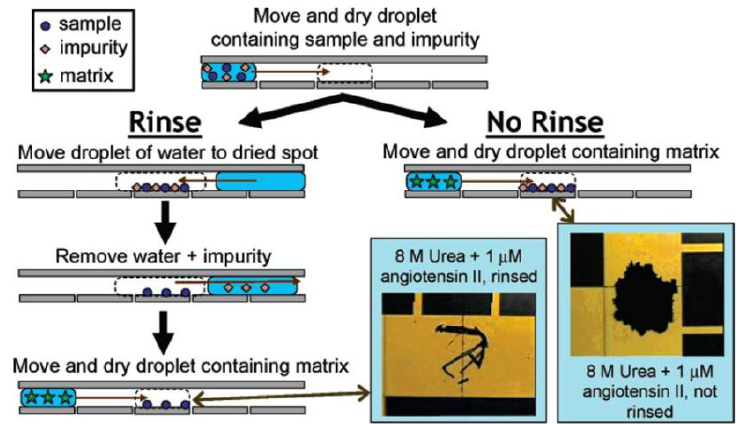
Figure 3. Digital microfluidic (DMF) systems are proven to be capable of handling the sample processing in Mass Spectrometry (MS), Electrowetting on Dielectrics (EWOD) combined with Matrix assisted laser desorption/ionization (MALDI). Reprinted with permission from [112], Copyright (2005) American Chemical